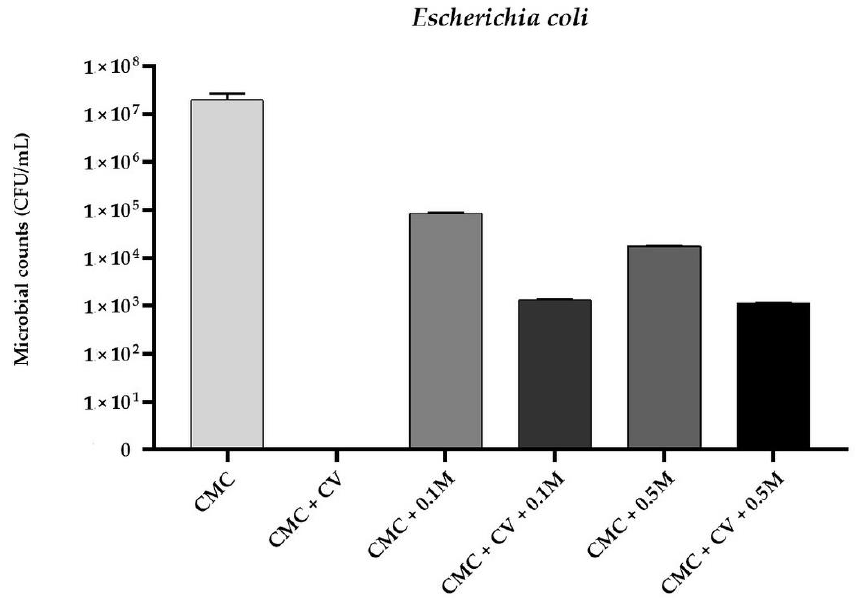
Figure 1. The effect of CMC-based neat and modified films on viability of Escherichia coli cells.